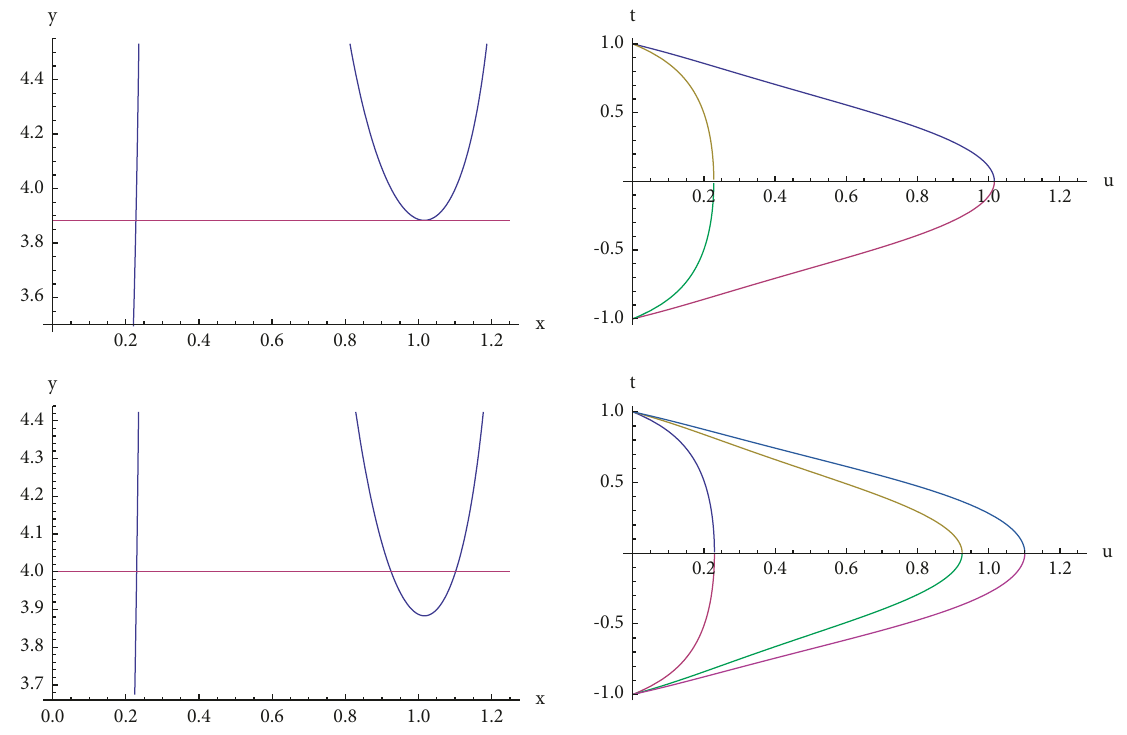
Figure 6: The multiple positive solutions for DBVP